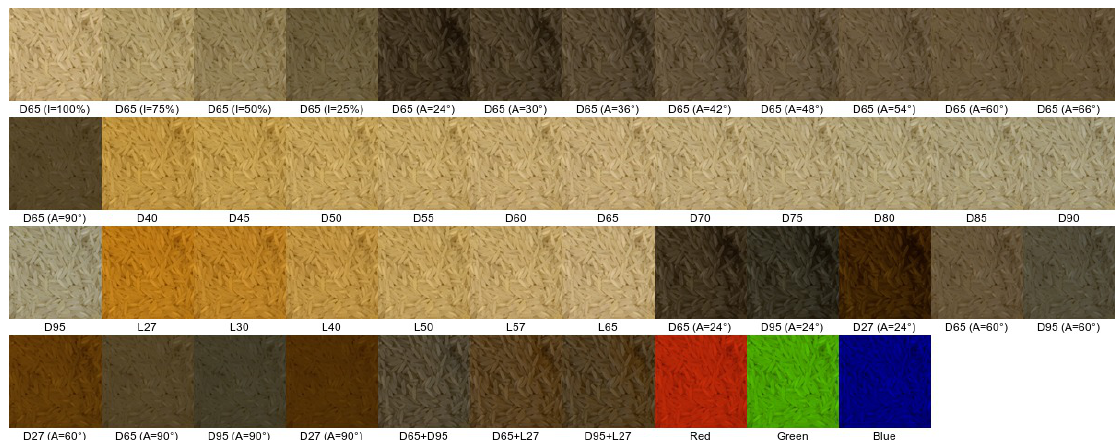
Figure 4. Example of the 46 acquisitions included in the RawFooT database for each class (here the images show the acquisitions of the “rice” class).